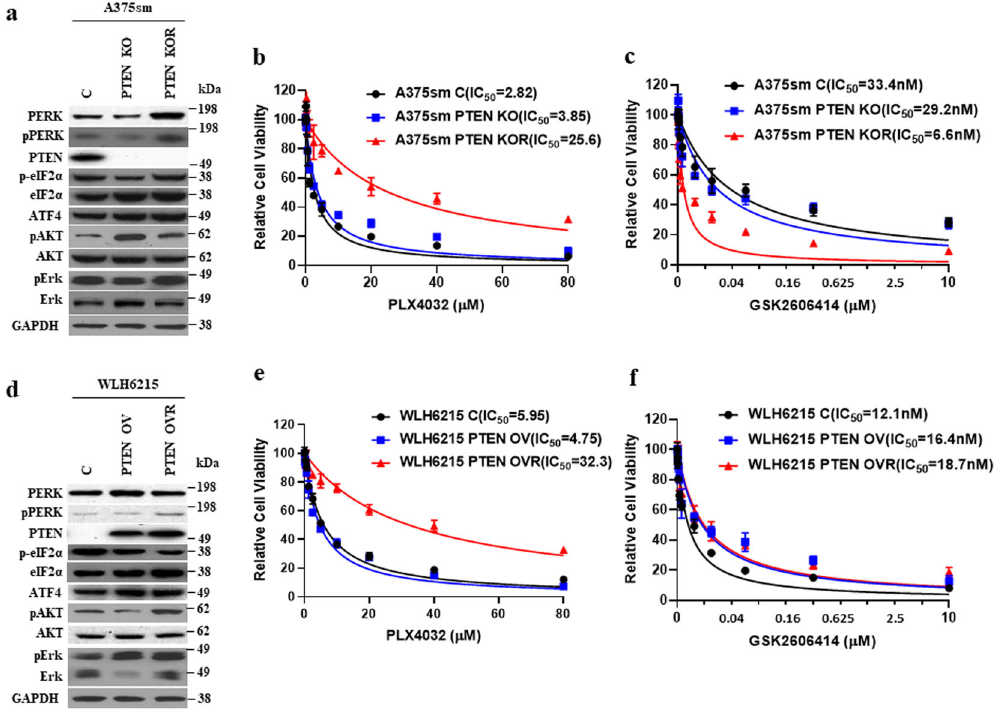
Fig. 4 PTEN status in fl uences the expression of PERK in BRAF V600E -mutated-resistant melanoma. a Western blot showed the indicated protein level in A375sm. C, empty vector; PTEN KO, PTEN knockout by gene editing; PTEN KOR, PTEN knockout A375sm resistance to BRAF inhibition. b Cell viability curves of A375sm with empty vector (A375sm C), A375sm PTEN knockout (A375sm-PTEN KO), and its BRAF inhibitor- resistant counterpart A375sm PTEN KO-R (A375sm-PTEN KOR) cells in response to PLX4032 were determined using CCK8 assay. Error bars denote s.d. for biological three repeats. c Cell viability curves of A375sm with empty vector (A375sm C), A375sm PTEN knockout (A375sm- PTEN KO), and its BRAF inhibitor-resistant counterpart A375sm PTEN KO-R (A375sm-PTEN KOR) cells in response to PERK inhibitor GSK2606414 were determined using CCK8 assay. Error bars denote s.d. for biological three repeats. d Western blot showed the indicated protein level in WLH6215 transfected with empty vector (C) and PTEN. C, empty vector; PTEN OV, PTEN overexpressing; PTEN OVR, PTEN overexpressing WLH6215 resistance to BRAF inhibition. e Cell viability curves of WLH6215 with empty vector (WLH6215 C), WLH6215 PTEN overexpressing (WLH6215 PTEN OV), and its BRAF inhibitor-resistant counterpart WLH6215 PTEN OV-R (WLH6215 PTEN OVR) cells in response to PLX4032 were determined using CCK8 assay. Error bars denote s.d. for biological three repeats. f Cell viability curves of WLH6215 with empty vector (WLH6215 C), WLH6215 PTEN OV (WLH6215 PTEN OV), and its BRAF inhibitor-resistant counterpart WLH6215 PTEN OVR (WLH6215 PTEN OVR) cells in response to PERK inhibitor GSK2606414 were determined using CCK8 assay. Error bars denote s.d. for biological three